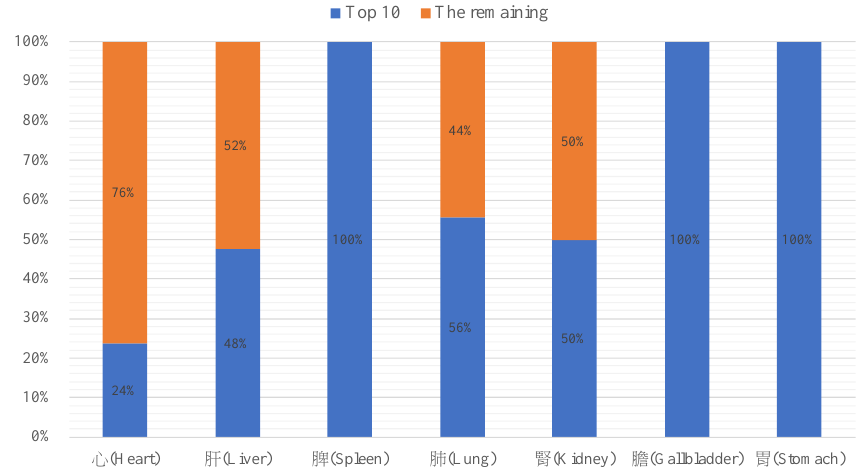
Figure 3. The ratio of top 10 descriptions of the five depots and two palaces.